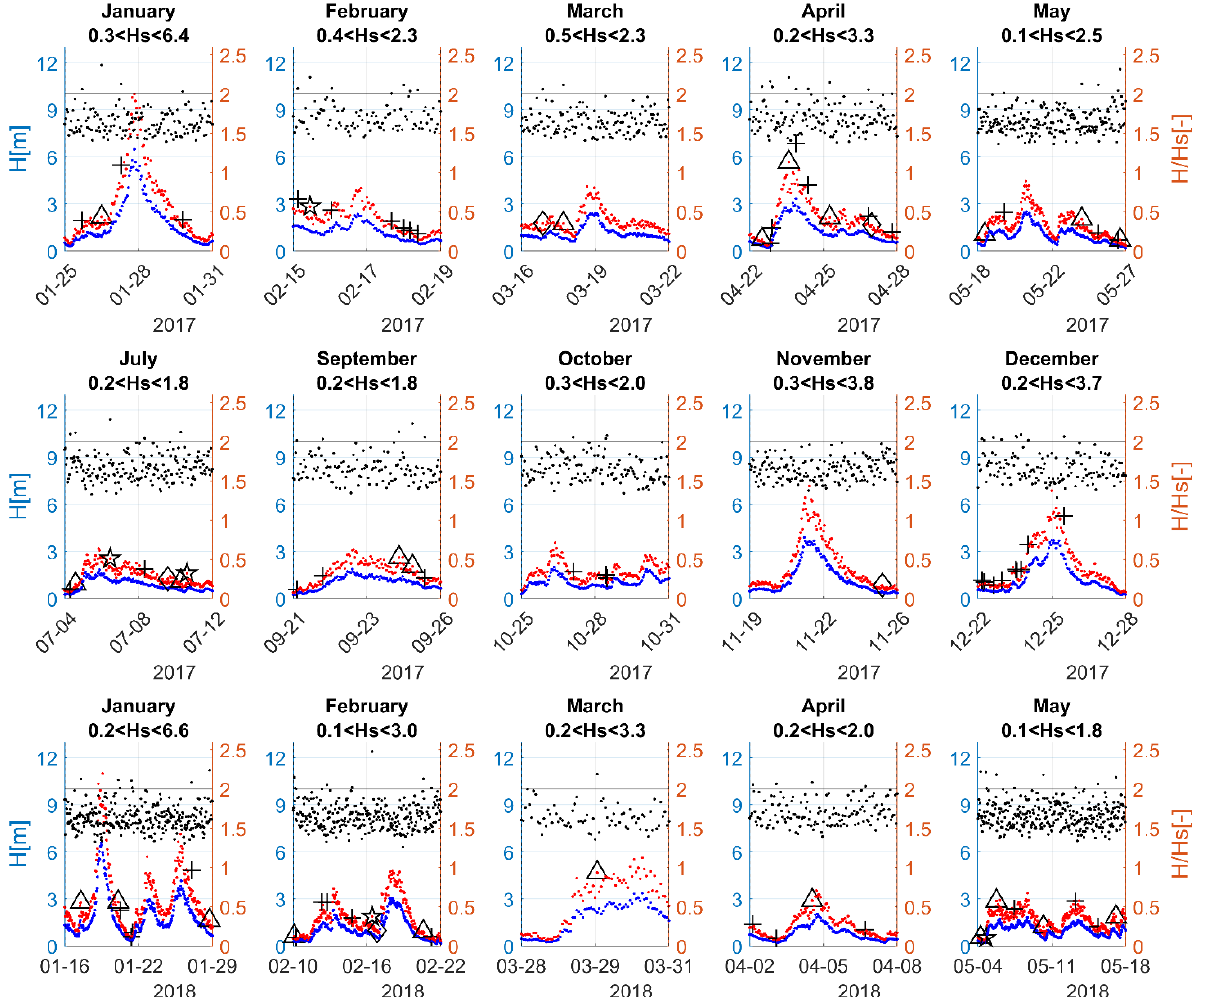
Figure 5. 20 high sea events. Detected rogue waves are marked in accordance with the threshold definition as standard definition H ≥ 2Hs denoted by +; crest height η c ≥ 1.25Hs denoted by ♦ ; STD of the instantaneous water elevation fluctuations H ≥ 8 σ η denoted by ∆ ; corresponds to all three threshold definitions denoted by ☆ . The left Y - axis colored in blue represents the wave height (significant wave height and maximal wave height). The right Y-axis colored in orange is the maximal wave height to significant wave height ratio.